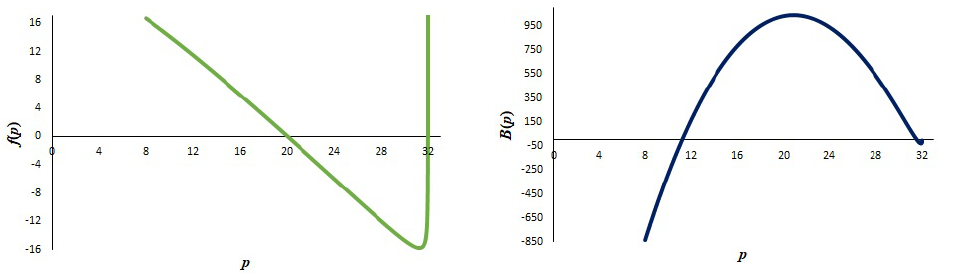
Figure 5. Functions f ( p ) and B ( p ) for Example